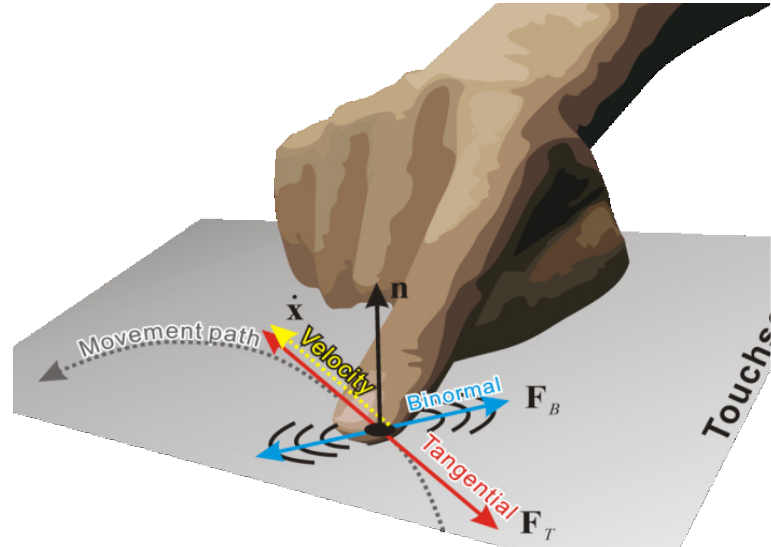
Figure 2. Binormaland tangential vibration: binormal vibration vibrate in binormal to movement direction, and tangential vibration vibrates in tangential to movement direction.